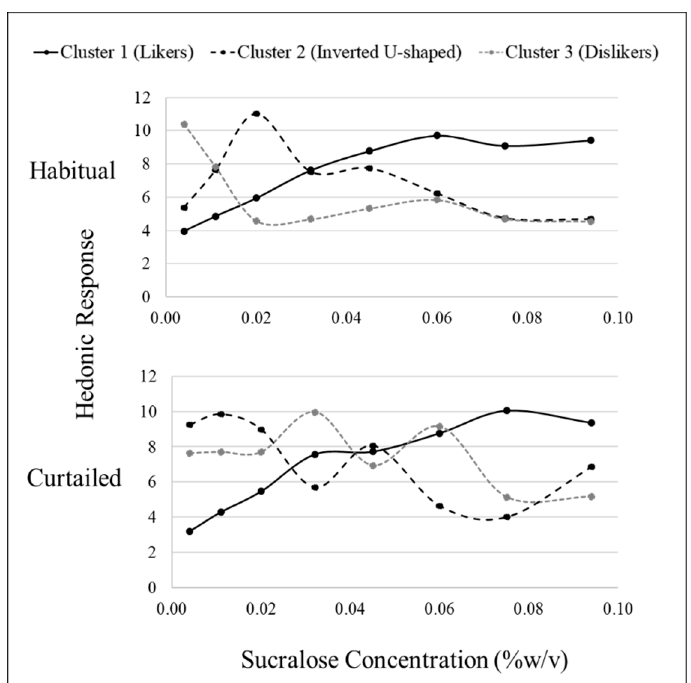
Figure 2. Hierarchical cluster analysis identified three sucralose sweet liking phenotypes based on sweet liking response using a 15 cm visual analog scale; however, patterns differed between habitual and curtailed nights. After the habitual night, cluster 1 ( n = 24), cluster 2 ( n = 10), and cluster 3 ( n = 6) demonstrated the fundamental phenotypes of sweet liking. After the curtailed night, cluster 1 ( n = 29) retained the familiar fundamental pattern of liking; whereas, cluster 2 ( n = 3) and cluster 3 ( n = 8) had distorted patterns.